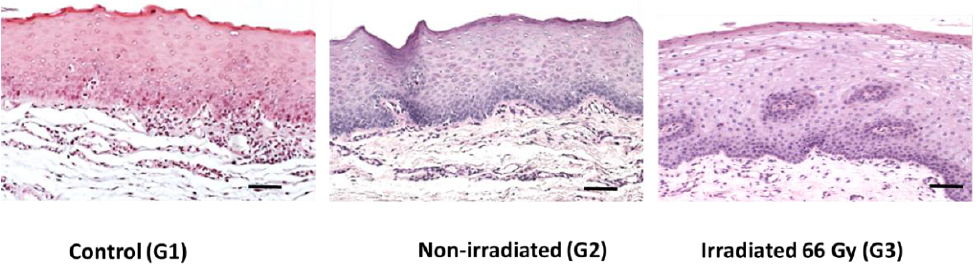
Figure 1. Hematoxylin and Eosin stained images showing differences in the superficial region of control, non-irradiated, and irradiated (Bar = 100 µm).